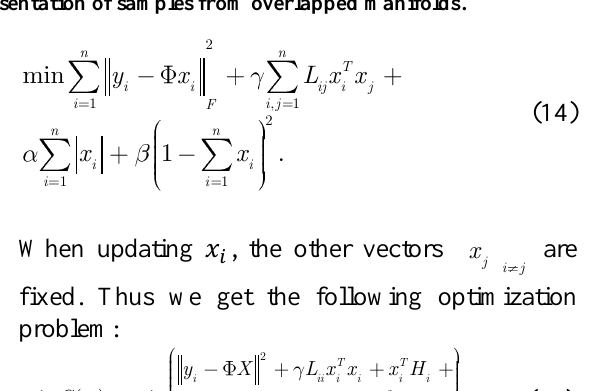
Figure 3. Effectiveness of Affinity constraint in representation of samples from overlapped